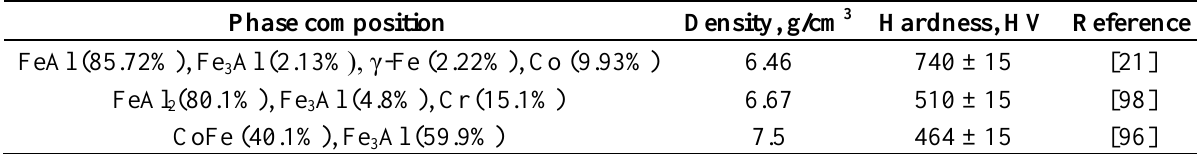
Table 2. Properties of the sintered